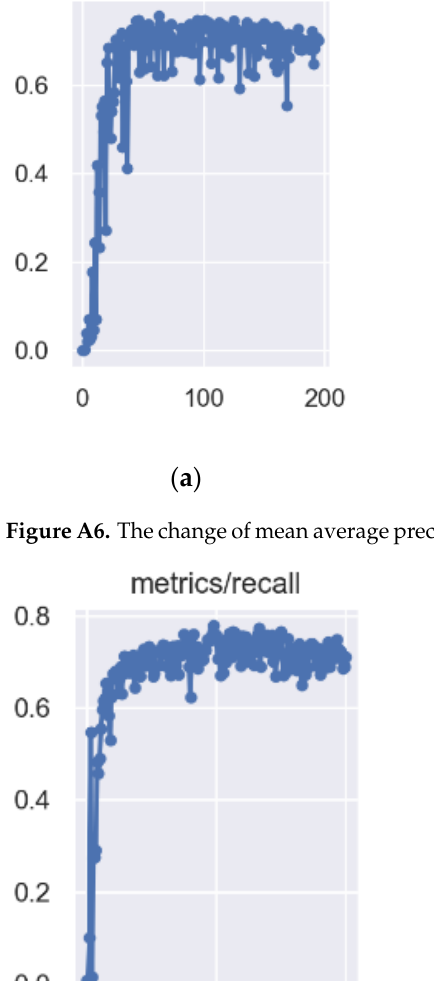
Figure A5. The precision/recall curve and F 1 Score /confidence curve of YOLOV5s: ( a ) PR_curve; ( b ) F1_curve.